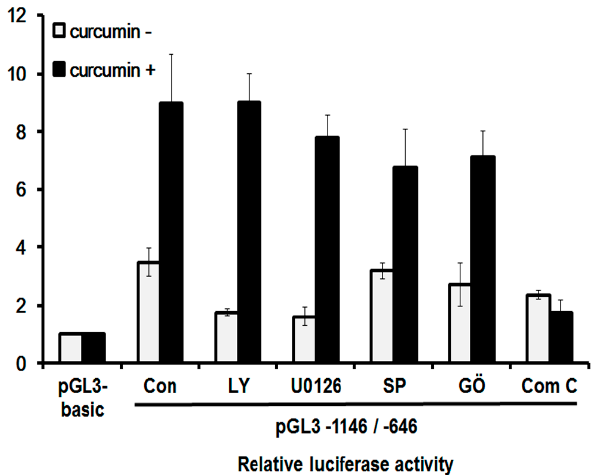
Figure 6. Effect of curcumin on signaling pathway for transcriptional activation of hST8Sia I A549 cells. The pGL3-1146/-646 (positive control), pGL3-basic (negative control), and pRL-TK (internal control) were co-transfected into A549 cells. Transfected cells were incubated in the presence (open bar) and absence (solid bar) of 40 μ M curcumin with LY294002 (10 μ M), U0126 (10 μ M), SP600125 (5 μ M), GO6983 (100 nM), and compound C (10 μ M) inhibitors for 24 h. Relative luciferase activity was normalized with the Renilla luciferase activity derived from pRL-TK. The values represent mean ± SEM for three independent experiments with triplicate measurements.